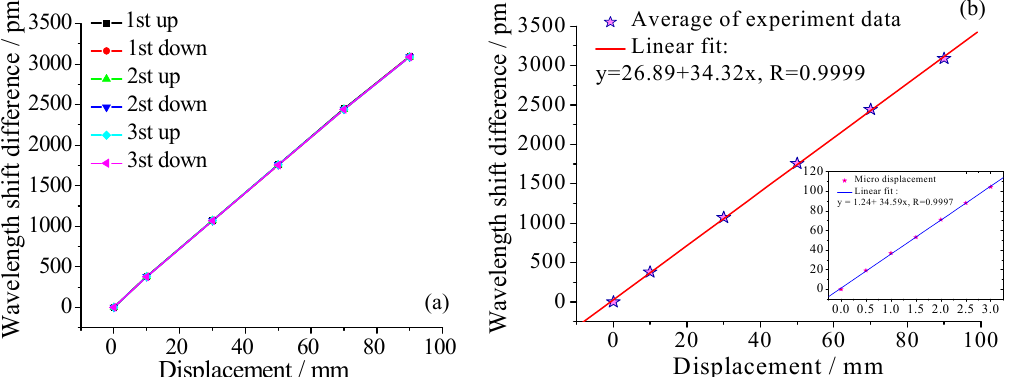
Figure 8. ( a ) The relationship of wavelength shift difference versus displacement; ( b ) Linear fit curve of average of experiment data and result of micro-displacement test.